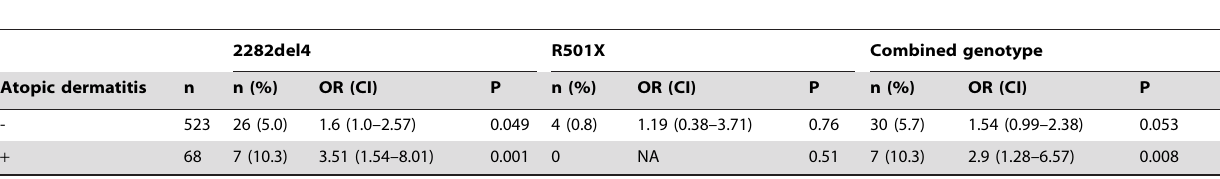
Table 4. Distribution of the FLG variants in subjects with persistent allergic rhinitis (pAR) stratified by diagnosis of atopic dermatitis.